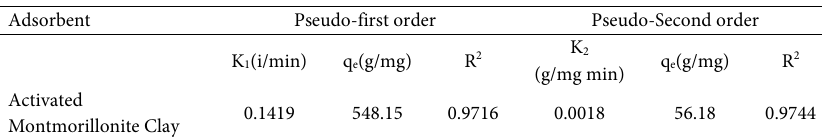
Table 5. Kinetic parameters of the fluoride adsorption on activated montmorillonite clay Adsorbent